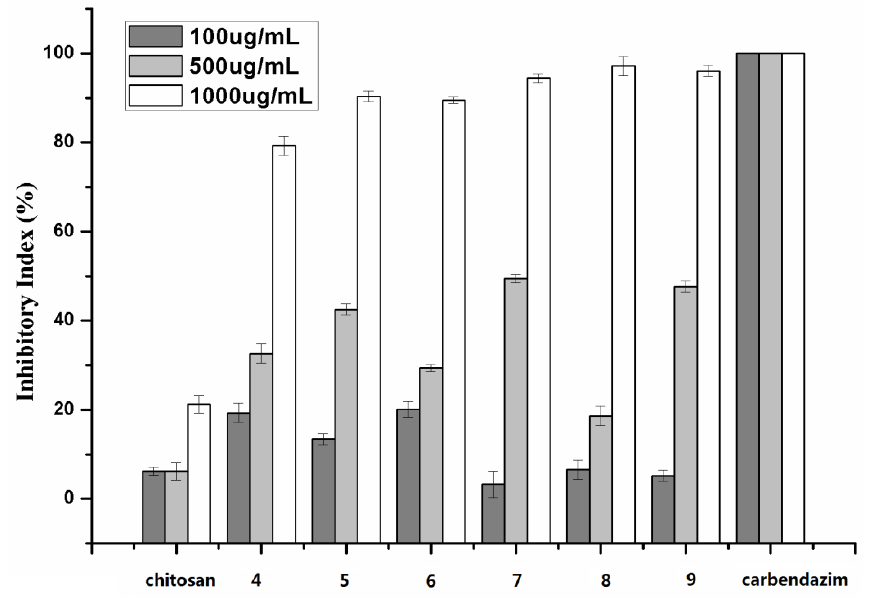
Figure 5. The antifungal activity of chitosan and chitosan derivatives against Phomopsis asparagi .